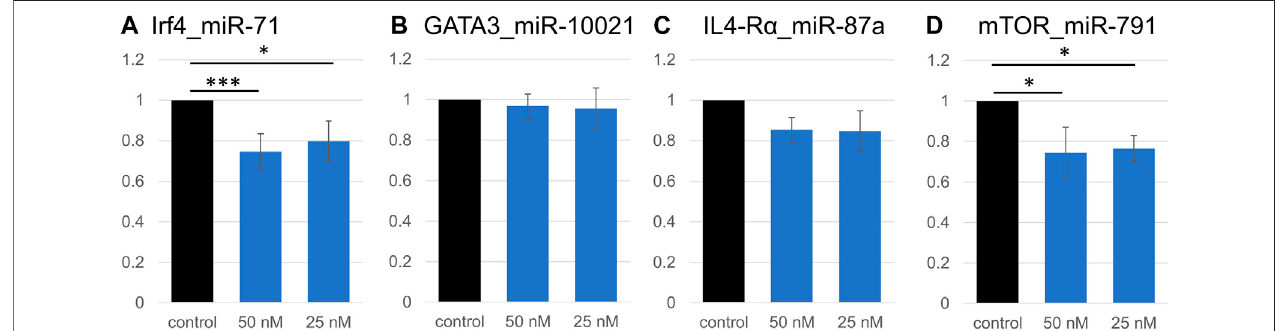
FIGURE 4 | Validation of direct interactions between miRNAs and predicted targets. Relative luciferase activity is signi fi cantly decreased due to the insertion of a miR-71 binding site on Irf4 (A) . Signal repression was stronger at 50 nM miRNA ( p < 0.001, t -test) than at 25 nM ( p = 0.02). Similarly, 50 nM or 25 nM miR-791 led to a decreaseinluminescencesignal( p =0.02and p =0.03,respectively; (D) ,con fi rminganinteractionbetweenmiR-791anditspredictedbindingsitein Mtor .Nosigni fi cant decrease in luminescence was detected in all other miRNA:binding site combinations ( Gata3 :miR-10021 (B) , and Il4ra :miR-87a (C) ). * p < 0.05, *** p <